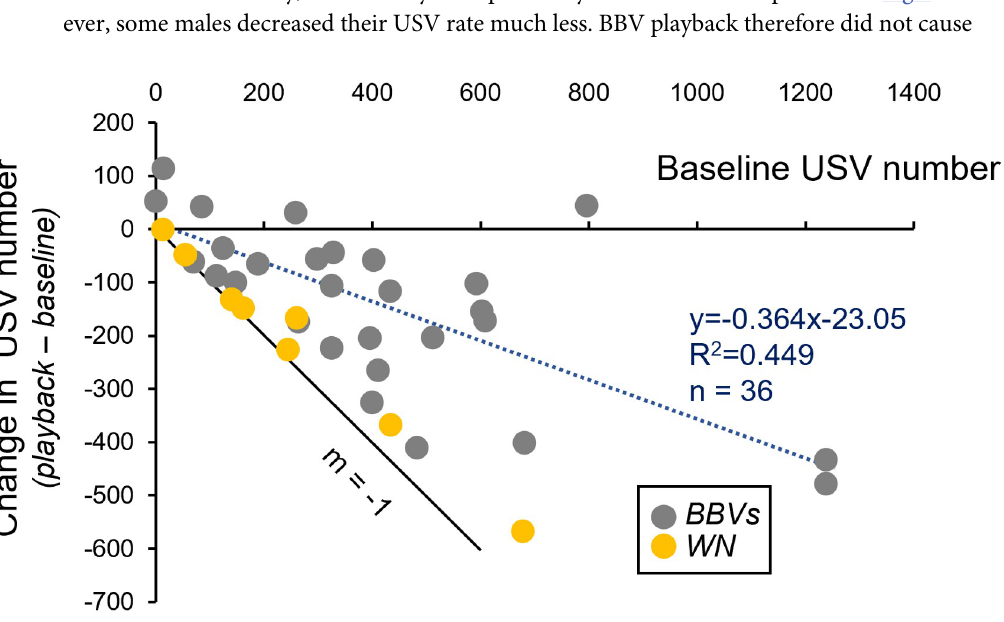
Fig 5. Comparison of changes in USV number induced by BBV playback relative to the baseline call number. Gray symbols mark trials using the 3 exemplar calls, and yellow symbols indicate trials using white noise (WN). The dashed line indicates the linear regression for all data points in the scatterplot. The solid line with a slope of -1 designate the maximum possible effect in which calls are totally suppressed during BBV playback.